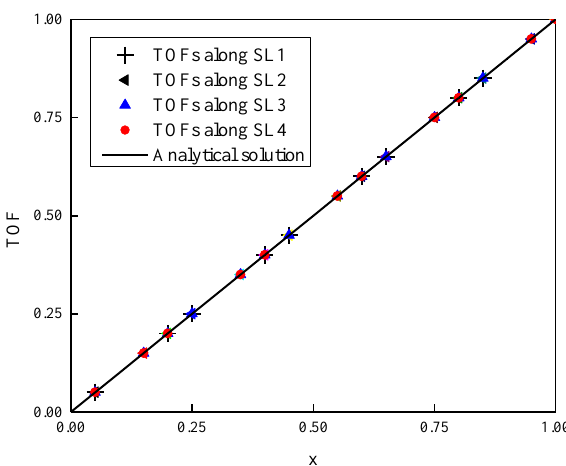
Figure 6. Comparison between analytical TOF shown as solid line and the calculated TOFs along four streamlines (SL1, SL2, SL3, and SL4) shown as discrete points.